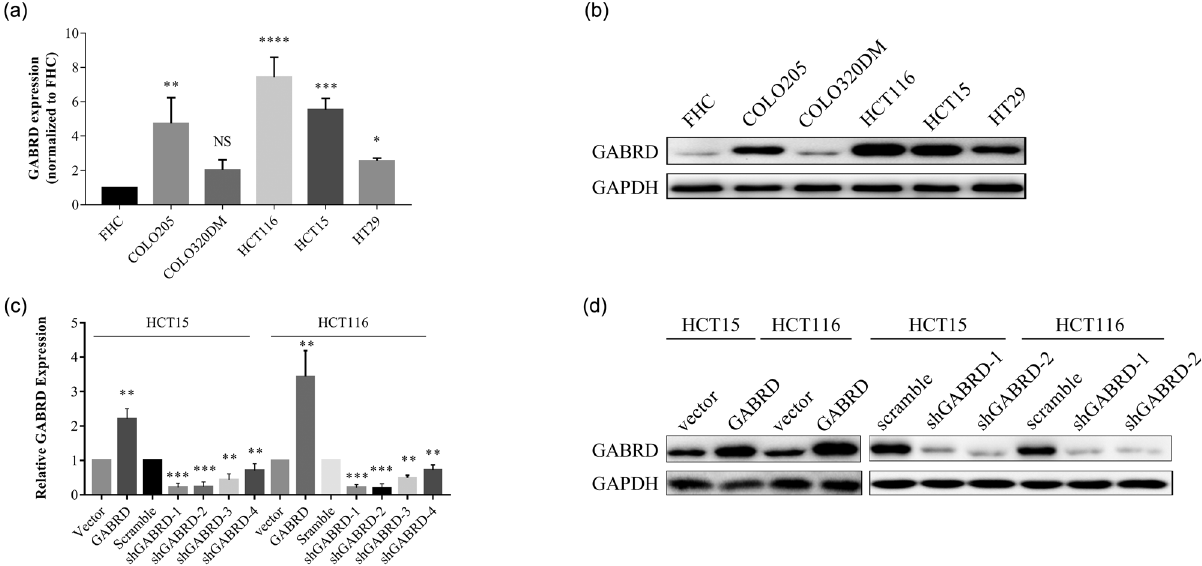
Figure 3: GABRD expression was upregulated in cultured CRC cell lines. The mRNA and protein expression of GABRD was investigated in a colon epithelial cell line FHC and fi ve CRC cell lines using q - PCR and western blotting. The results demonstrated that the GABRD expression was dramaticallyincreasedinfouroftheCRCcelllinescomparedtothatinthecolonepithelialcelllineFHC ( aandb ) .TwoCRCcelllineswereselectedand transducedwithvector,GABRD,scrambleshRNA,orGABRDshRNAs,thenunderwentq - PCRandwesternblottingtodetectGABRDexpressioninthese cells ( c and d ) . Abbreviations: CRC, colorectal cancer; GABRD, gamma - aminobutyric acid type A receptor subunit delta; GAPDH,